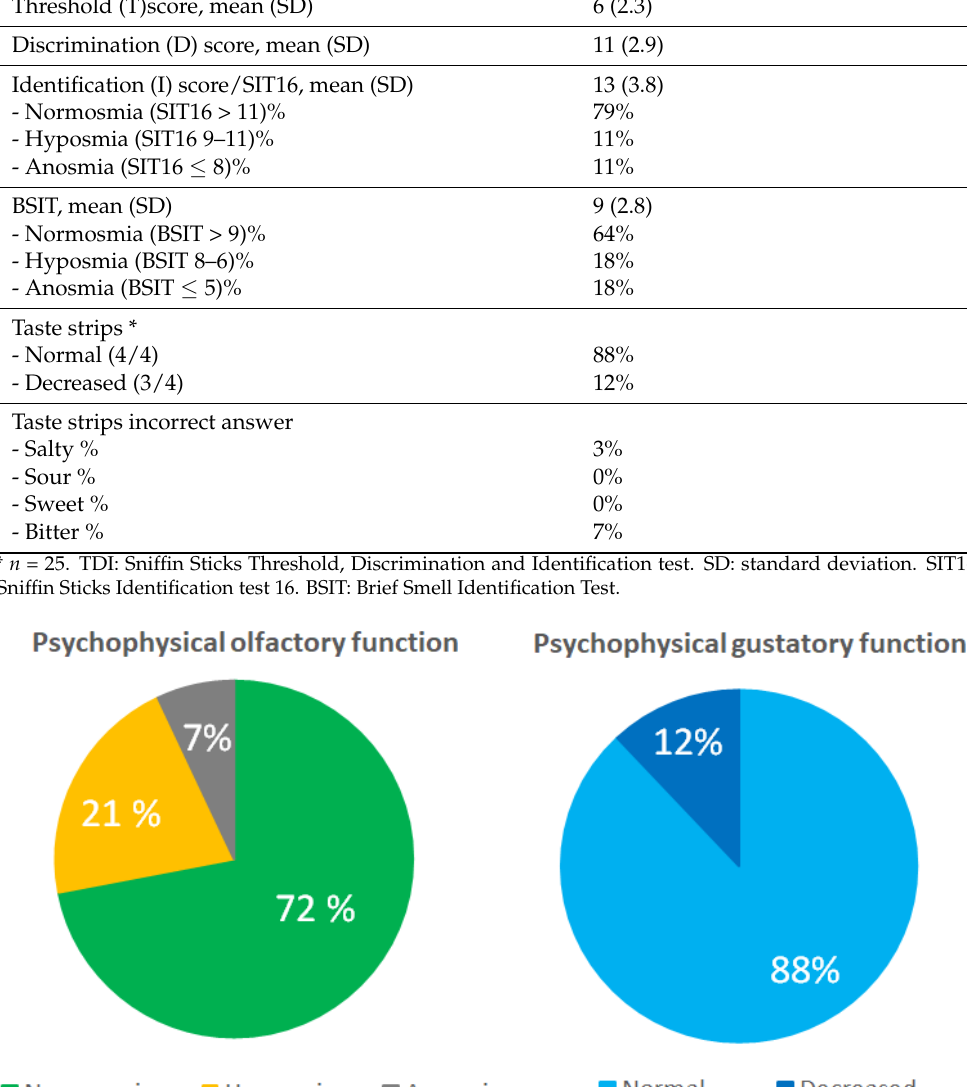
Figure 1. HRQoL; patients’ ability to navigate everyday life using their sense of smell and taste 3–6 months after hospitalisation for COVID-19 ( n = 29). The black box shows the percentage of patients where this ability was decreased.